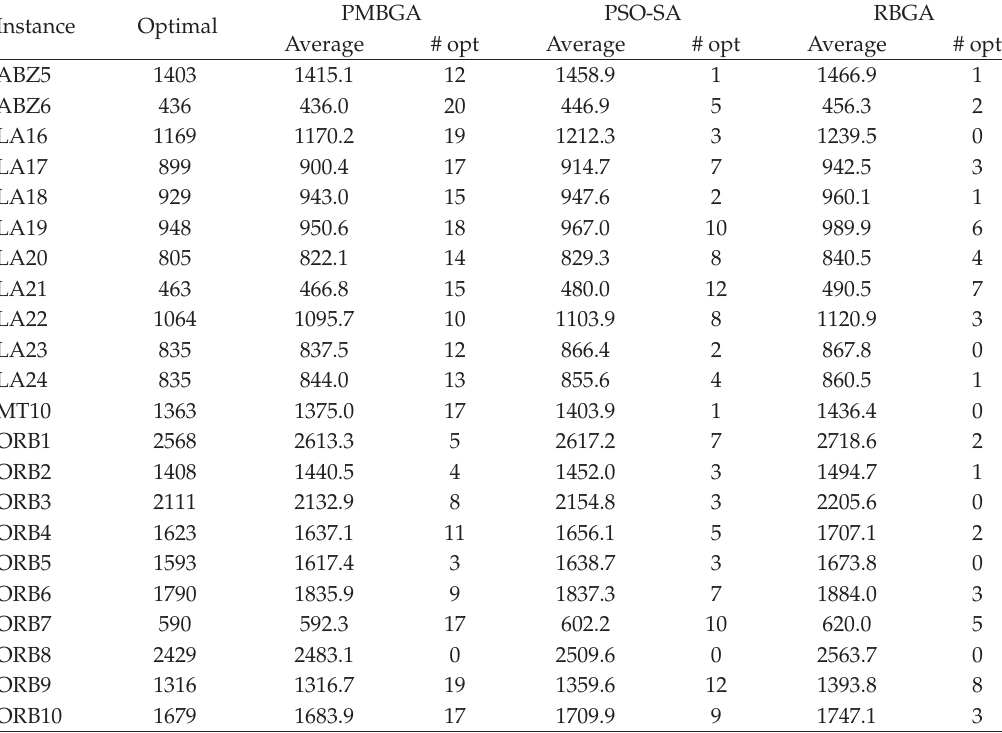
Table 3: The computational results and comparisons under f (cid:9) 1 .